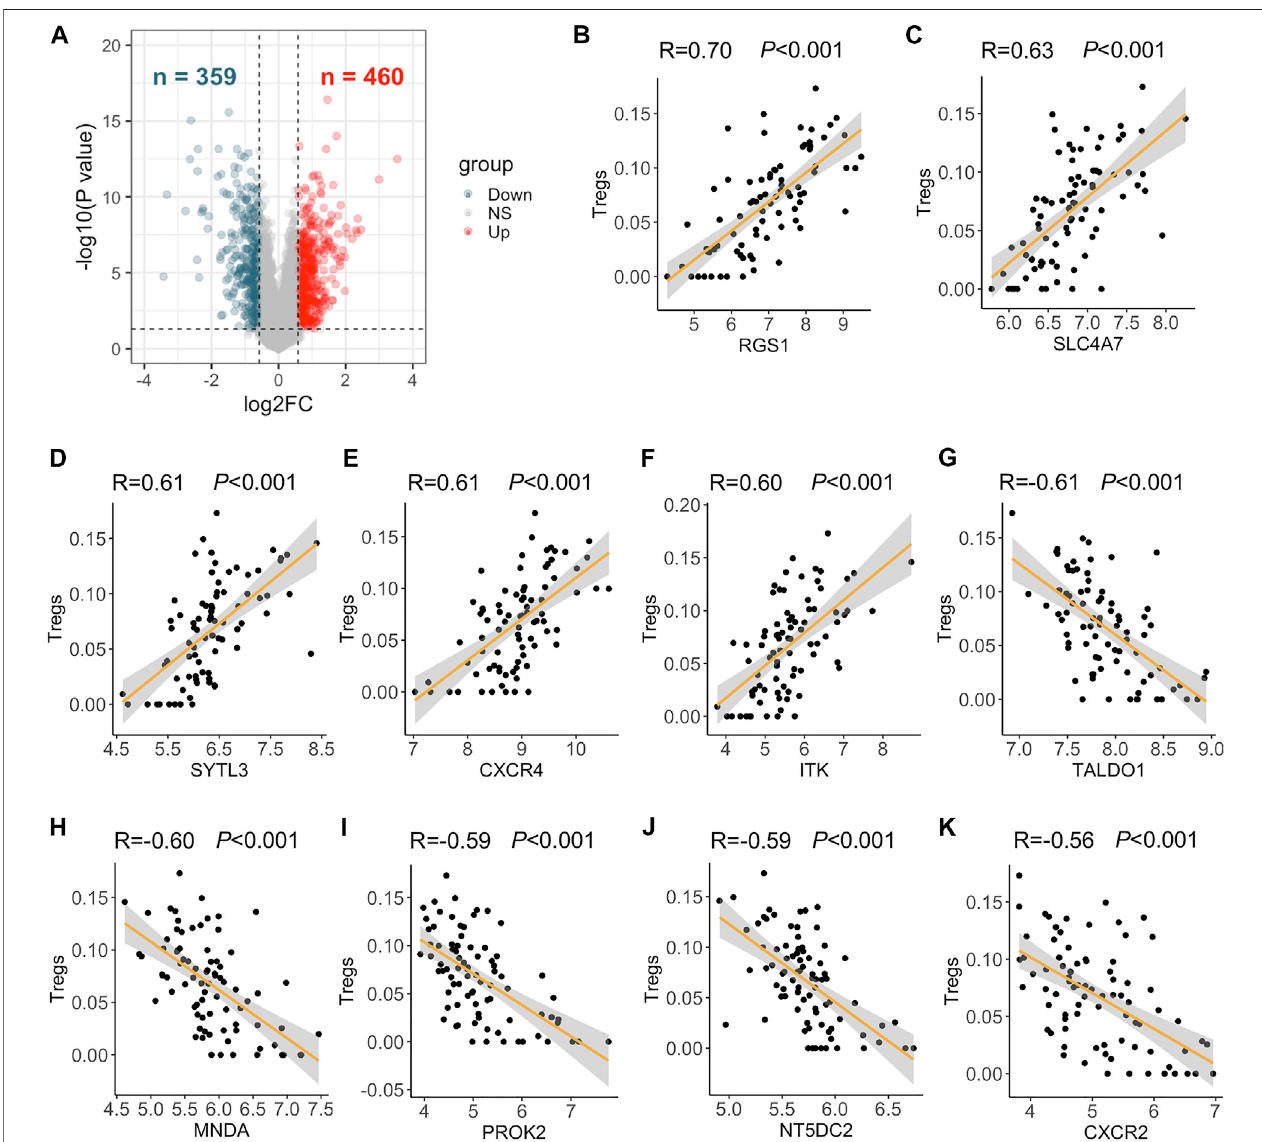
FIGURE 1 | Differentially expressed genes (DEGs) and top fi ve DEGs positively and negatively correlated with the abundance of Tregs. (A) DEGs between 58 PAH patients and 25 control subjects of the GSE117261 dataset were visualized in volcano plots (fold change > 1.5 or < 0.67 and p < 0.05). Red dot represents upregulated DEGs,anddarkbluedotrepresentsdownregulatedDEGsinPAHpatientscompared tocontrolsubjects. (B – F) RGS1 (B) ; SLC4A7 (C) ; SYTL3 (D) ; CXCR4 (E) ;and ITK (F) were DEGs most positively correlated with the abundance of Tregs as analyzed by Pearson correlation analysis. (G – K) TALDO1 (G) ; MNDA (H) ; PROK2 (I) ; NT5DC2 (J) ; and CXCR2 (K) were DEGs most negatively correlated with the abundance of Tregs as analyzed by Pearson correlation